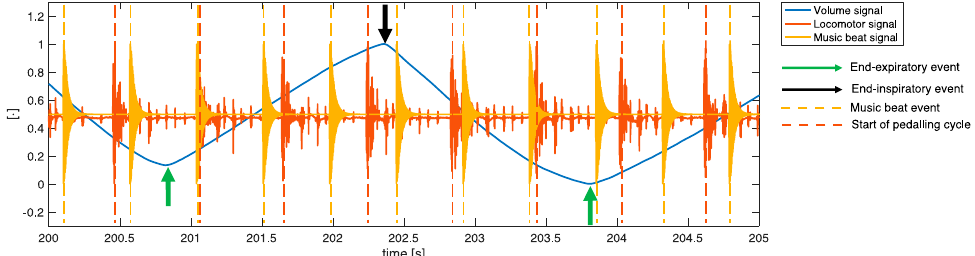
Figure 5. Graphical description of how the events used for the computation of entrainment were identified from the breathing volume signal, the locomotor signal, and the music beat signal.